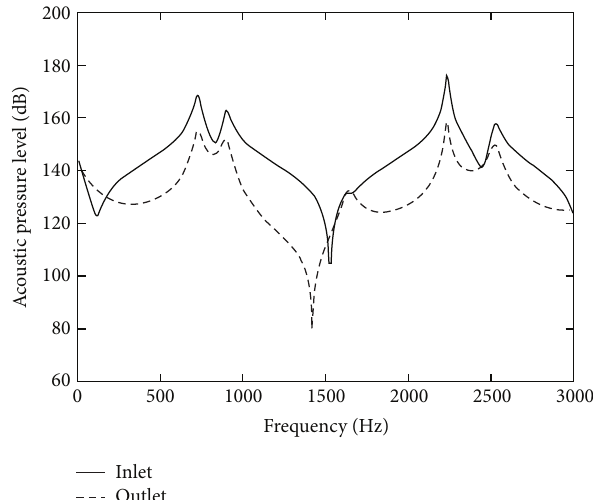
Figure 9: Acoustic pressure level for the inlet and outlet of the expansion chamber silencer with inlet flow velocity of V = 10.2 m/s.